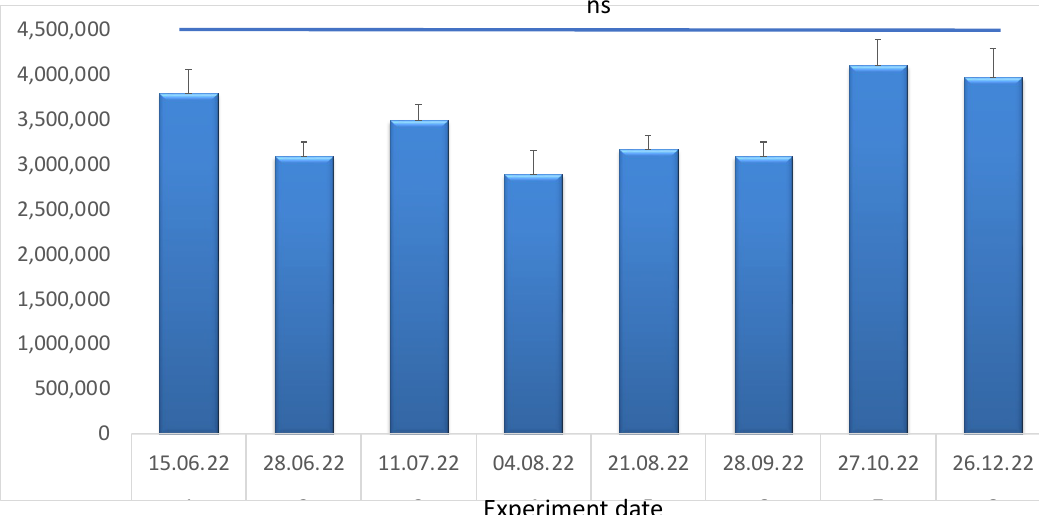
Figure 9. The e ffi ciency of cell transfection with lipoplexes prepared from LNPs with di ff erent struc- tural lipids. Phospholipid composition: 100% DOPE (sample S1), 100% DOPC (sample S4), and 50:50 DOPE/DOPC (sample S5). Incubation time was 24 h. ( a ) HEK 293T cells, ( b ) MDA-MB-231 cells, ( c ) SW 620 cells. The untreated controls did not di ff er from the background signal (700 counts per 10 s) and are not displayed. ****, A statistically signi fi cant di ff erence, p < 0.0001, n = 3. ns, not signi fi cant.